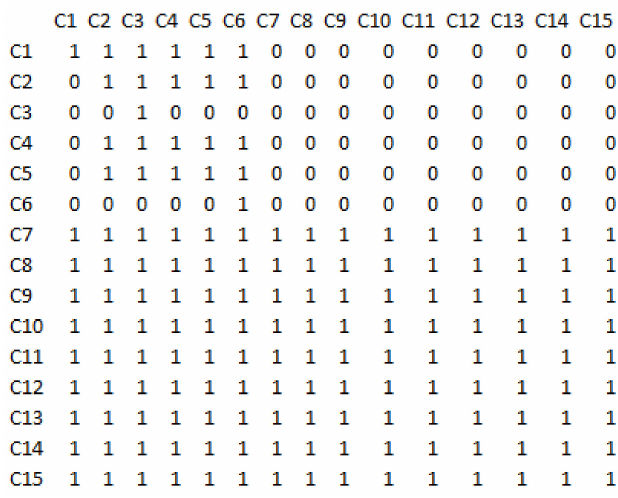
Figure 6. The total-relation matrix in the structural interpretive modelling technique.